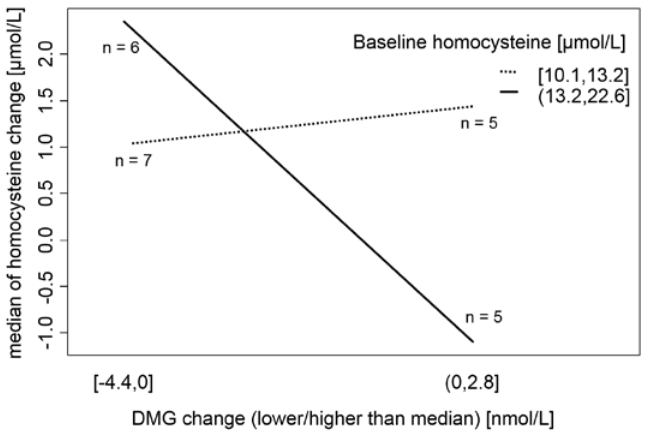
Figure 3. Interaction of DMG changes and baseline Hcy concentrations in relation to Hcy changes in the wine-only group after a month of drinking 375 mL of white wine daily. In participants with a baseline concentration of Hcy over its median (13.2 µmol/L), the change in Hcy levels after the wine-drinking period was significantly determined by the change in DMG, whereas in participants with lower baseline Hcy values, the BHMT system did not determine Hcy change. Table 4. Factors determining Hcy change during white wine drinking without vitamin supplementation (wine-only group). Adjusted R 2 : 0.62; p = 0.00095.